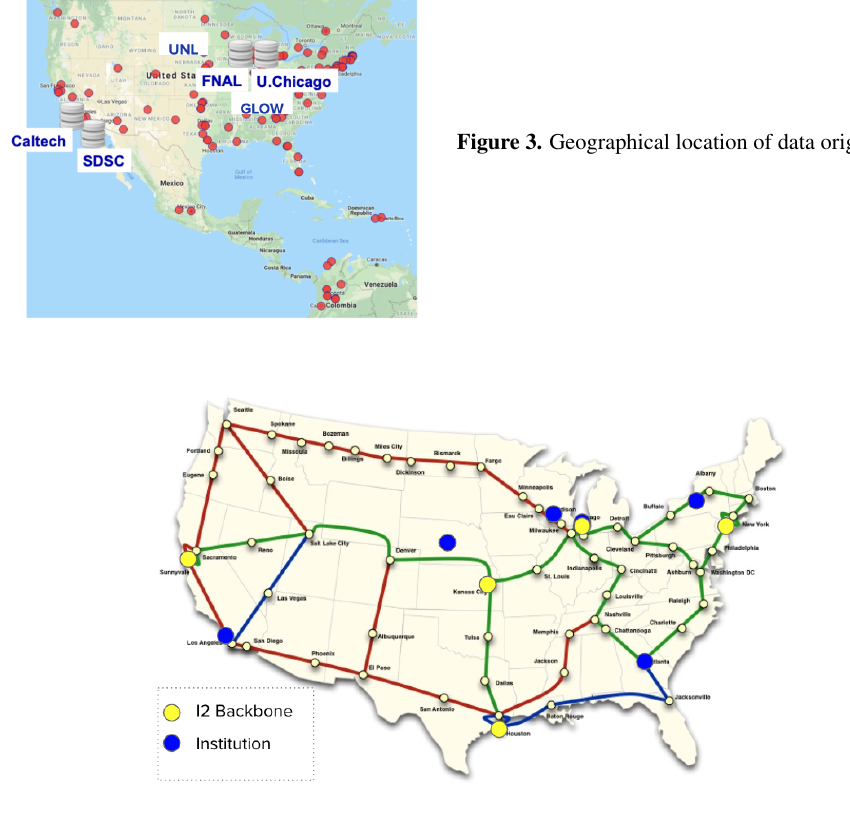
Figure 4. Geographical location of Stashcache in the US internet